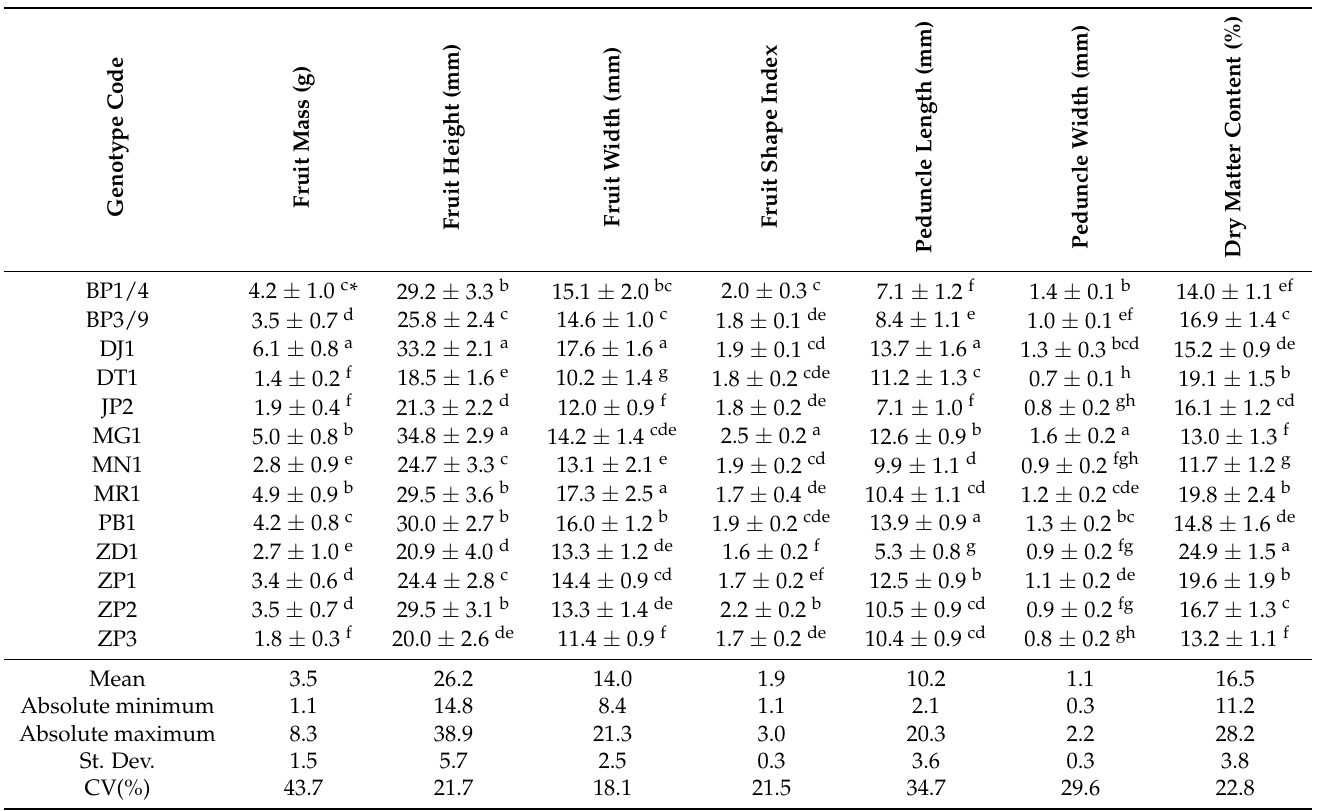
Table 4. Pomological traits of Morus sp. genotypes.